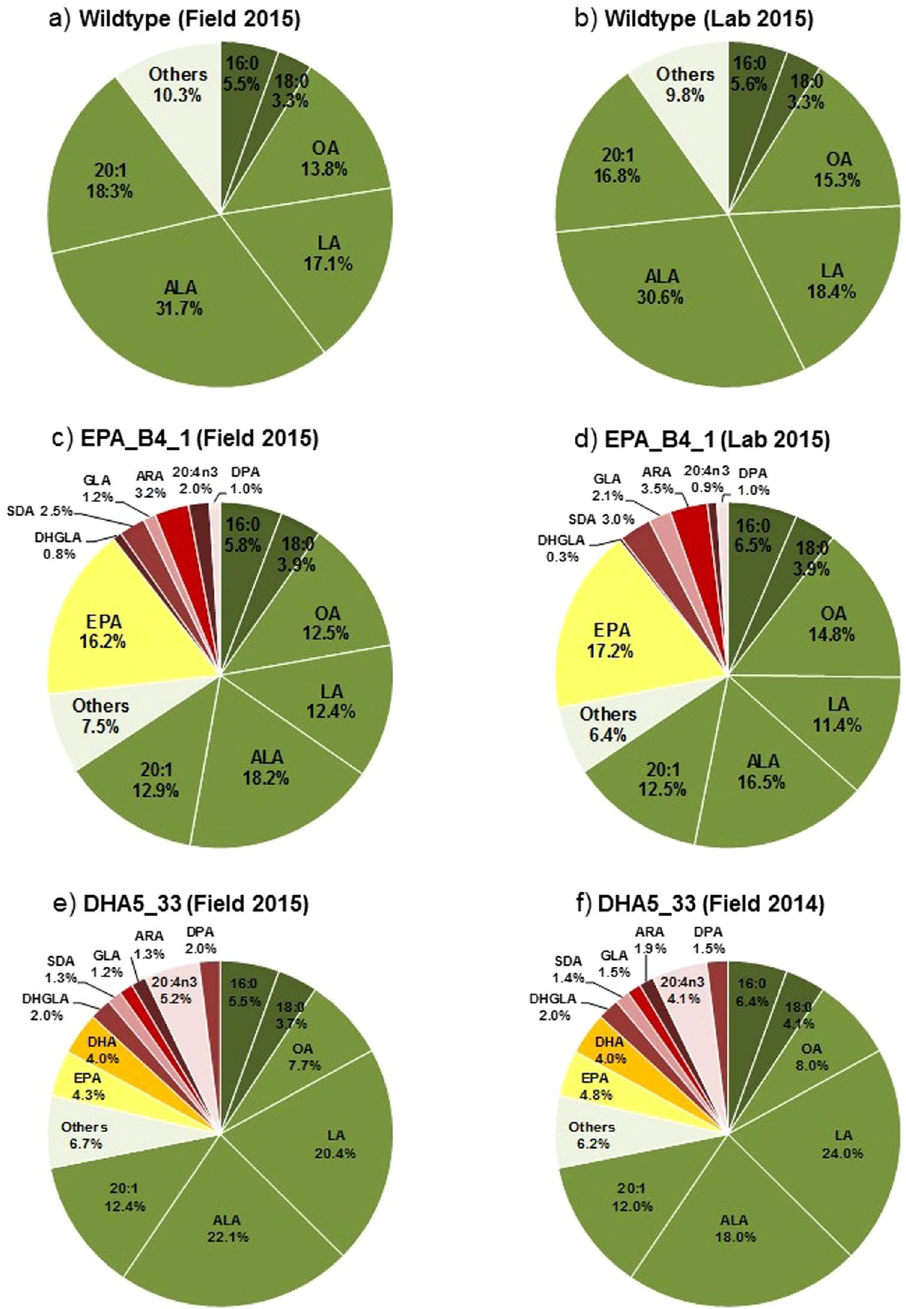
Figure 2. Total fatty acid composition (mol%) of laboratory and field-grown wild-type and engineered C. sativa seeds. Distribution of FAMEs in wildtype C. sativa grown (2015) in the field ( a ) and laboratory ( b ); the EPA producing line EPA_B4_1 grown (2015) in the field ( c ) and laboratory ( d ); and a comparison of the DHA producing line, DHA5_33, grown in the field in 2014 ( e ) and 2015 ( f ). An average of 75 seeds analysed by GC- FID (flame ionisation detection). Endogenous fatty acids are shown in shades of green; intermediates of the introduced biosynthetic pathway are shown in shades of red, and the key target fatty acids (EPA and DHA) are shown in shades of